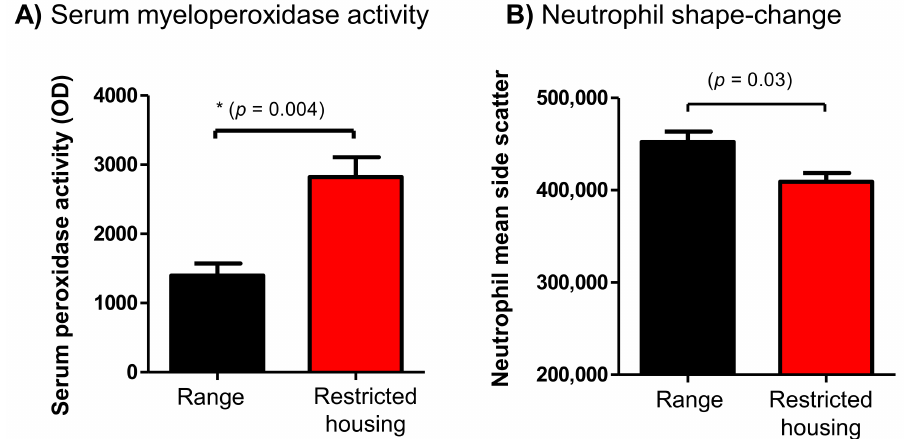
Figure 1. Analysis of serum myeloperoxidase activity and neutrophil shape-change. ( A ) Serum sam- ples were collected from the camels before and after restricted housing and analyzed for myeloperoxi- dase activity using a colorimetric assay. Optical density (OD) values are presented for free-range and restricted-housing animals as mean ± standard error of the mean (SEM). ( B ) Neutrophil shape-change was analyzed by the assessment of neutrophil side scatter values using flow cytometry. The student’s t -test was used to compare the means, and the * p -value is indicated on the